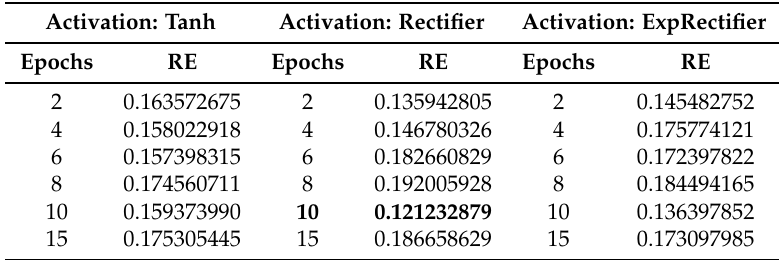
Table 4. Relative Error (RE) results for Deep Learning (DL) in the parameter optimization process.